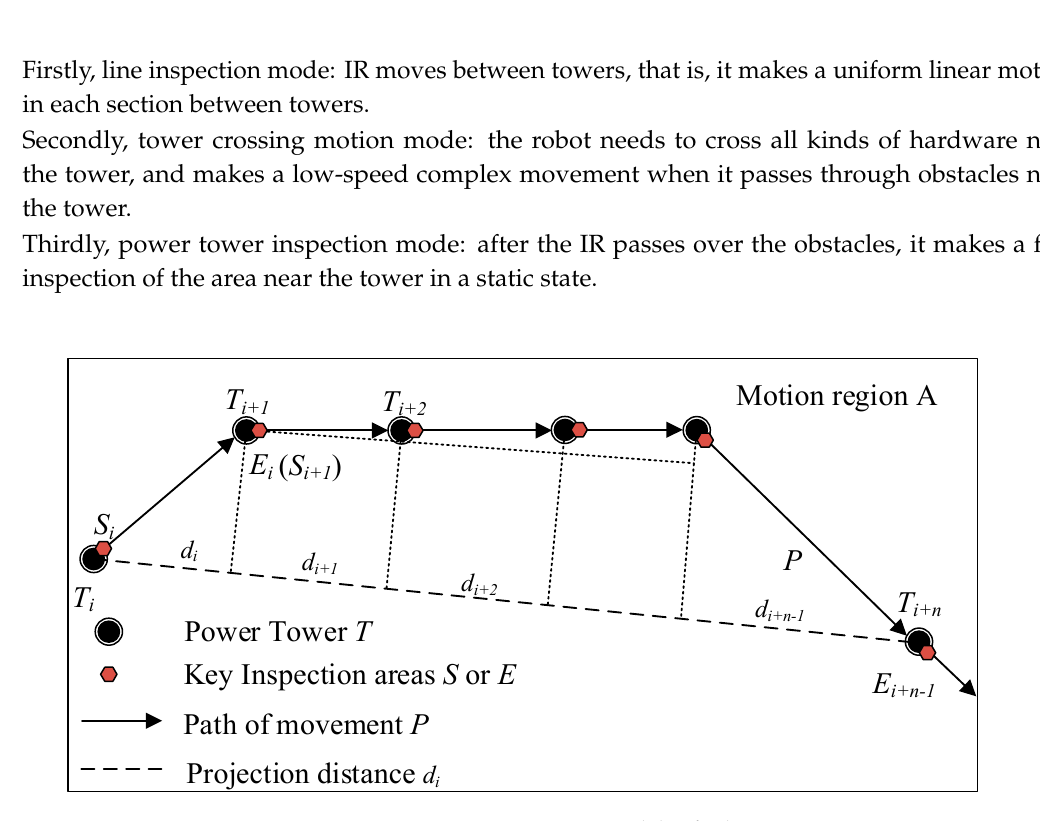
Figure 4. Inspection movement models of robot.